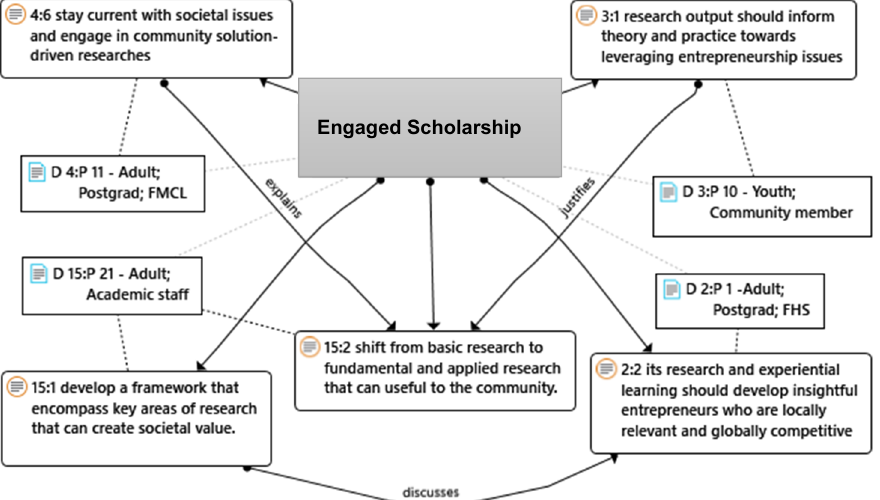
Figure 3. Engaged scholarship.